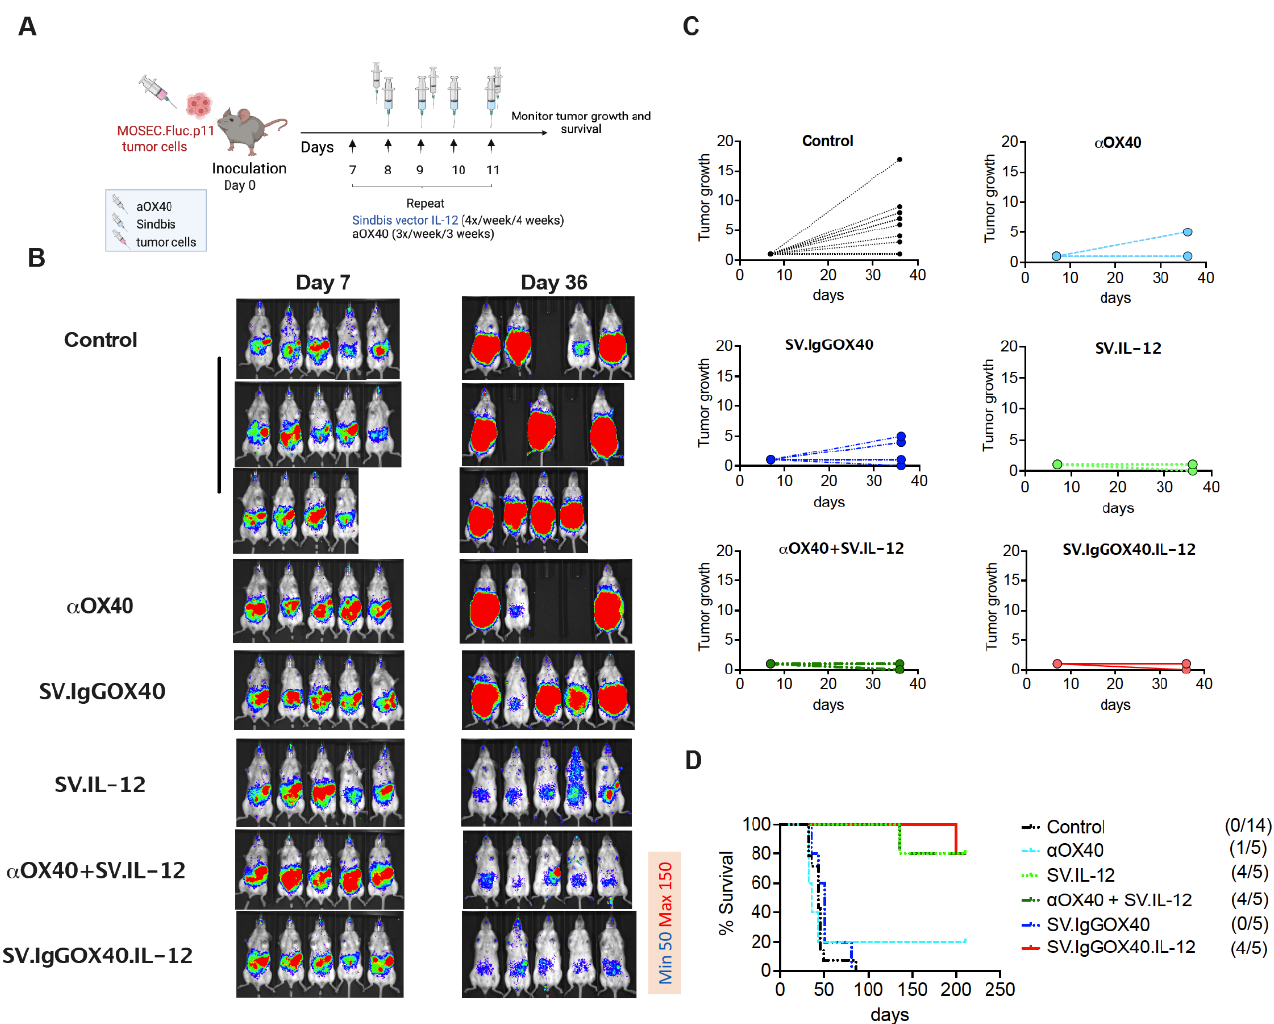
Figure 4. SV vector platform significantly suppresses established ovarian cancer tumors in vivo. ( A ) Experimental protocol for the ovarian cancer model used in ( B – D ). C57BL/6 mice were given an i.p. injection of SV.IL-12, SV.IgGOX40, SV.IgGOX40.IL-12, and/or α OX40 at the indicated times after injection of 2.5 × 10 6 MOSEC.Fluc.p11 cells on day 0. ( B ) Representative bioluminescence images of control and treated tumor-bearing mice. ( C ) MOSEC.Fluc.p11 tumor growth curves shown as bio- luminescence (RLU) (RLU day X/ RLU first day) over time for each mouse. Each line represents an individual mouse. Top left graph: control ( n = 14), middle left graph: SV.IgGOX40 ( n = 5), bottom left graph: α OX40+SV.IL-12 ( n = 5). Top right graph: α OX40 ( n = 5), middle right graph: SV.IL-12 ( n = 5), bottom right graph: SV.IgGOX40.IL-12 ( n = 5). ( D ) Survival plot of control and treated mice bearing peritoneally disseminated MOSEC.Fluc.p11tumors. Hazard ratios (untreated/treated) were determined with the Mantel-Haenszel method. SV.IgGOX40 (1.837), α OX40+SV.IL-12 (10.5), α OX40 (0.9921), SV.IL-12 (10.5), SV.IgGOX40.IL-12 (10.5). Results are representatives of at least two inde- pendent experiments.